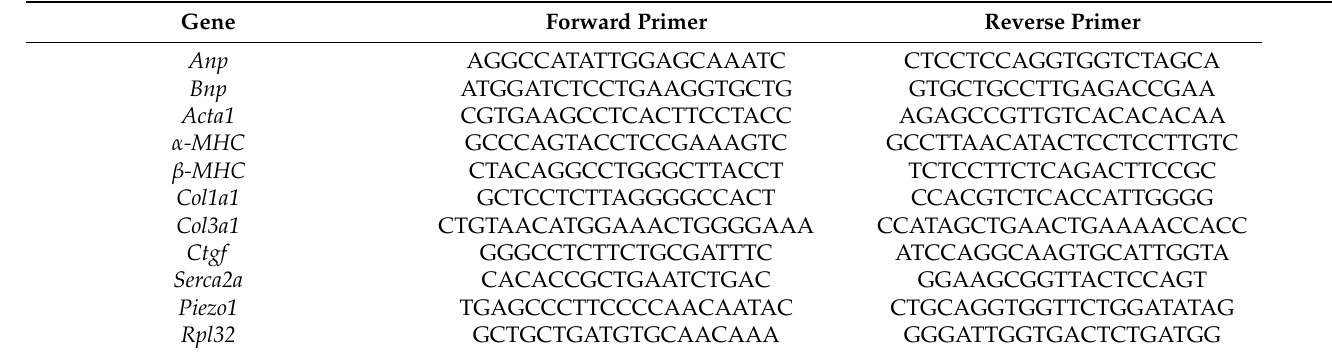
Table 1. List of primers used for RT-qPCR of heart